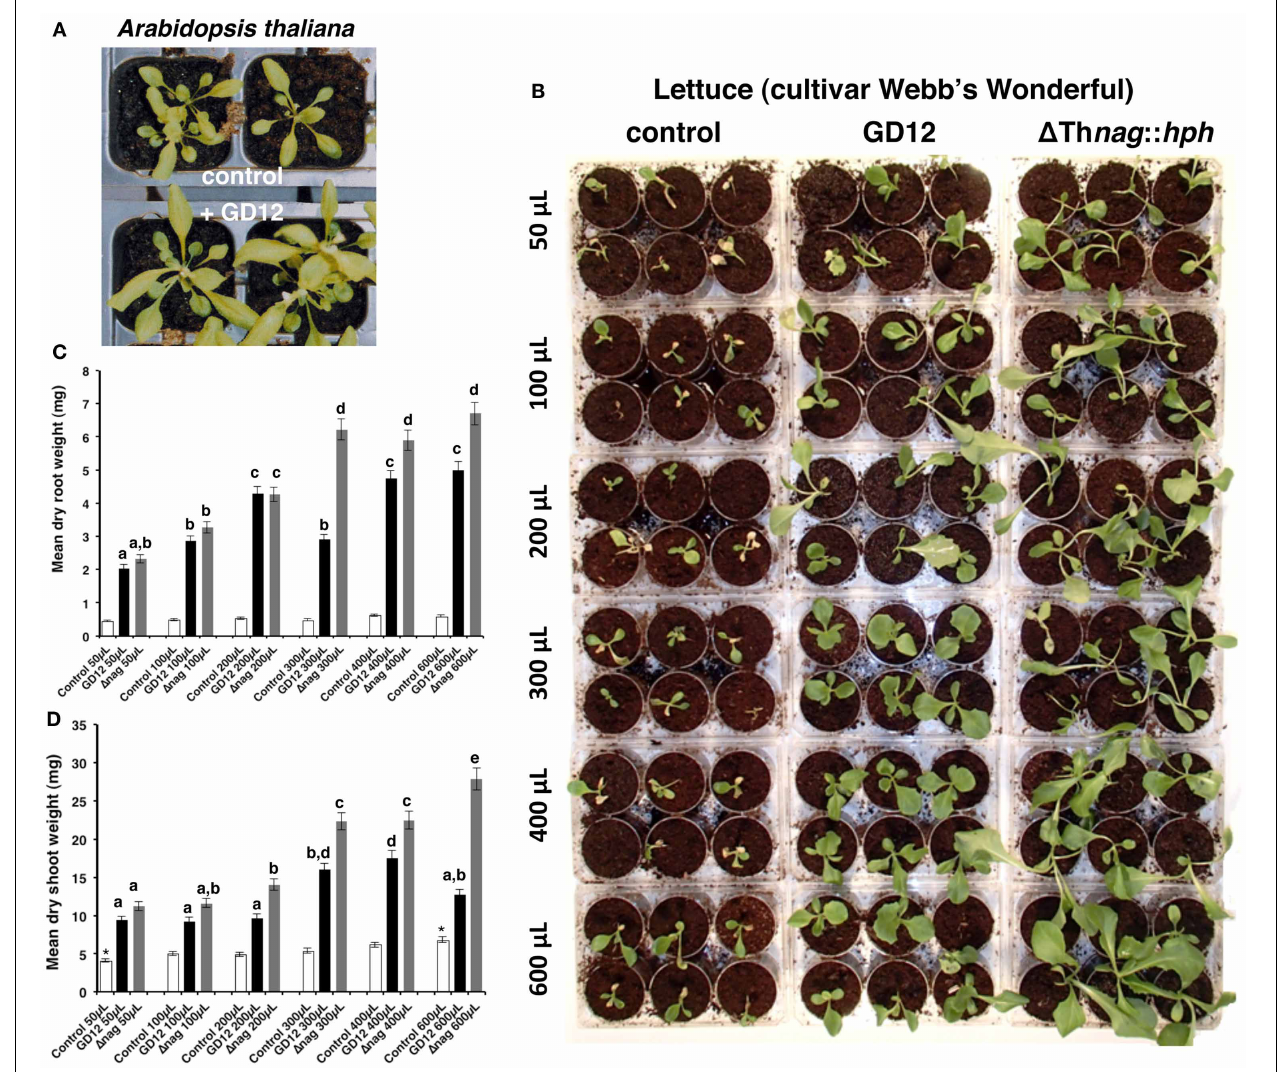
The photograph, taken 21 days after sowing is representative of a microcosm replicate. Histogram showing dry weights of lettuce root (C) or shoot (D) biomass 21 days after growth in peat microcosms supplemented by application of sterilized bran extracts. Each plant was treated with the indicated amount of metabolite extract from either T. hamatum strain GD12 (black bars) or (cid:2) Thnag::hph ( (cid:2) nag; gray bars) on alternate days. Control plants (white bars) were watered with dH 2 O. Each bar represents the mean of 25 samples, each with 3 experimental replicates ± SE. Same letter denote no significant difference and ∗ denote significant difference at 95% confidence level ( t